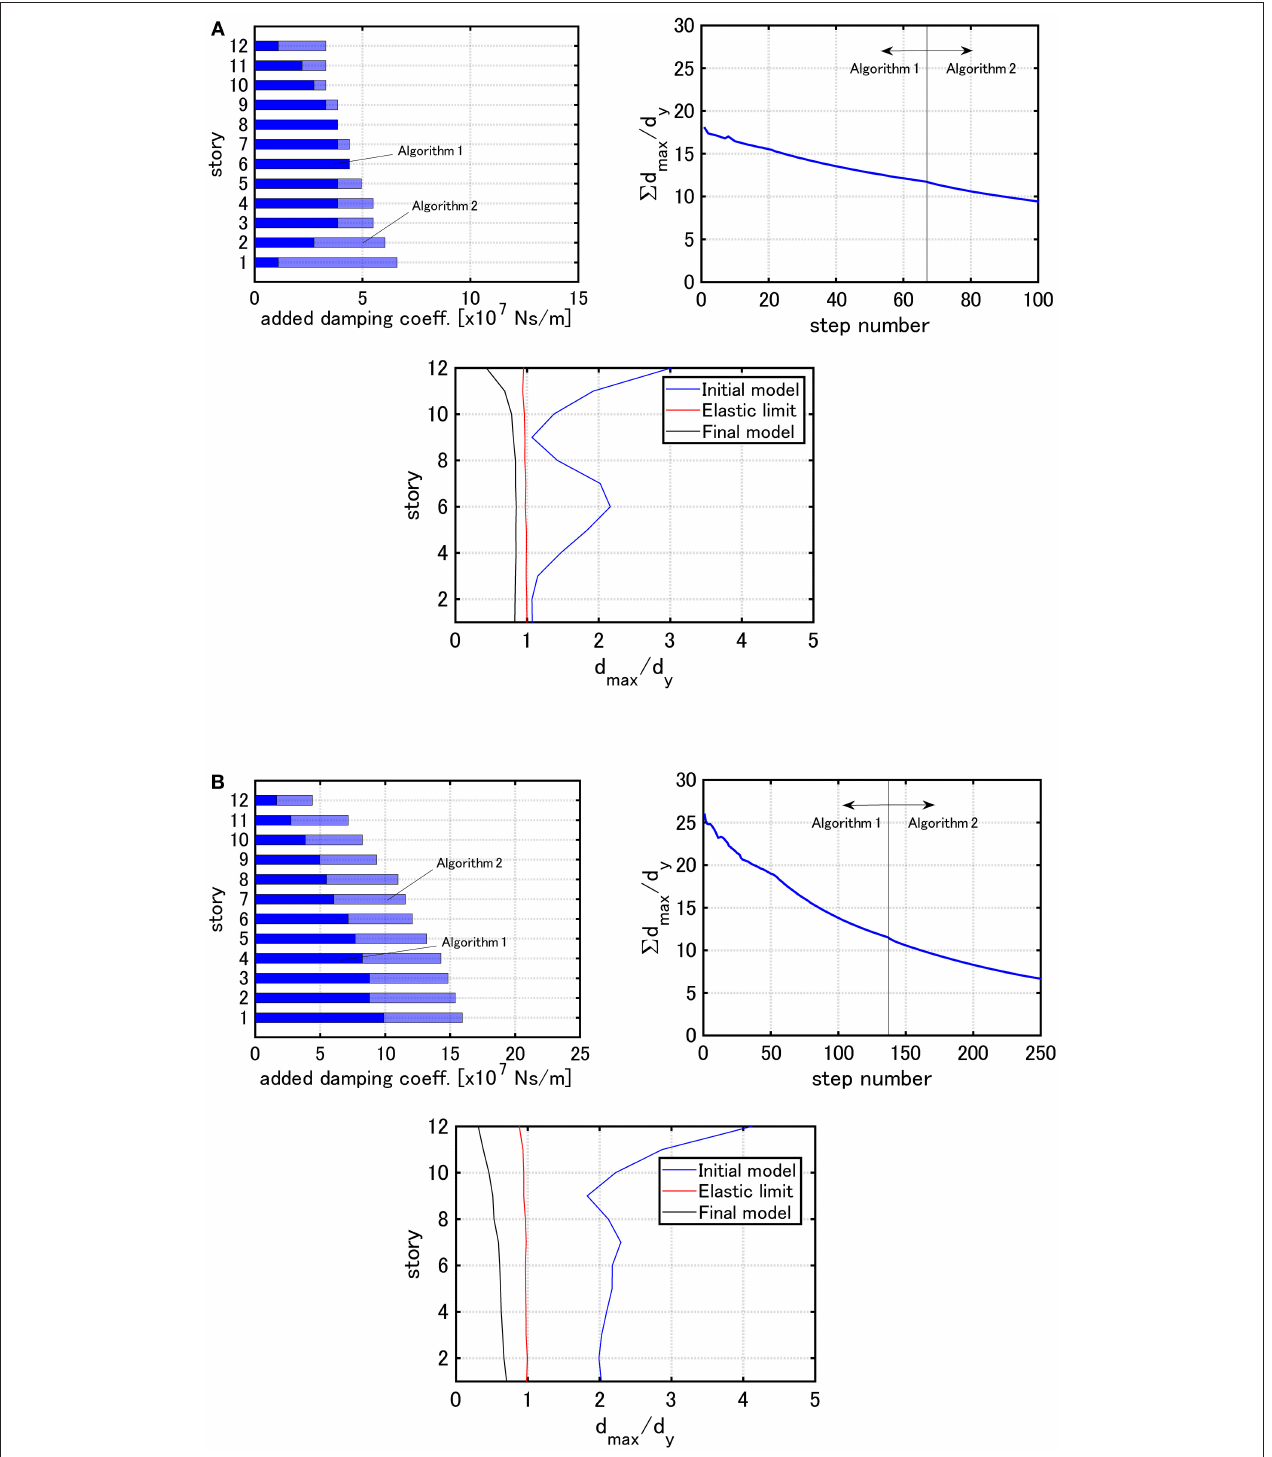
FIGURE 13 | Distribution of added damping coefficients, P d max , i / d y with respect to step number and the distribution of d max , i / d y under the critical double impulse for Model 2 (Problem 3): (A) V = 0.84[m/s], (B) V = 1.23[m/s].